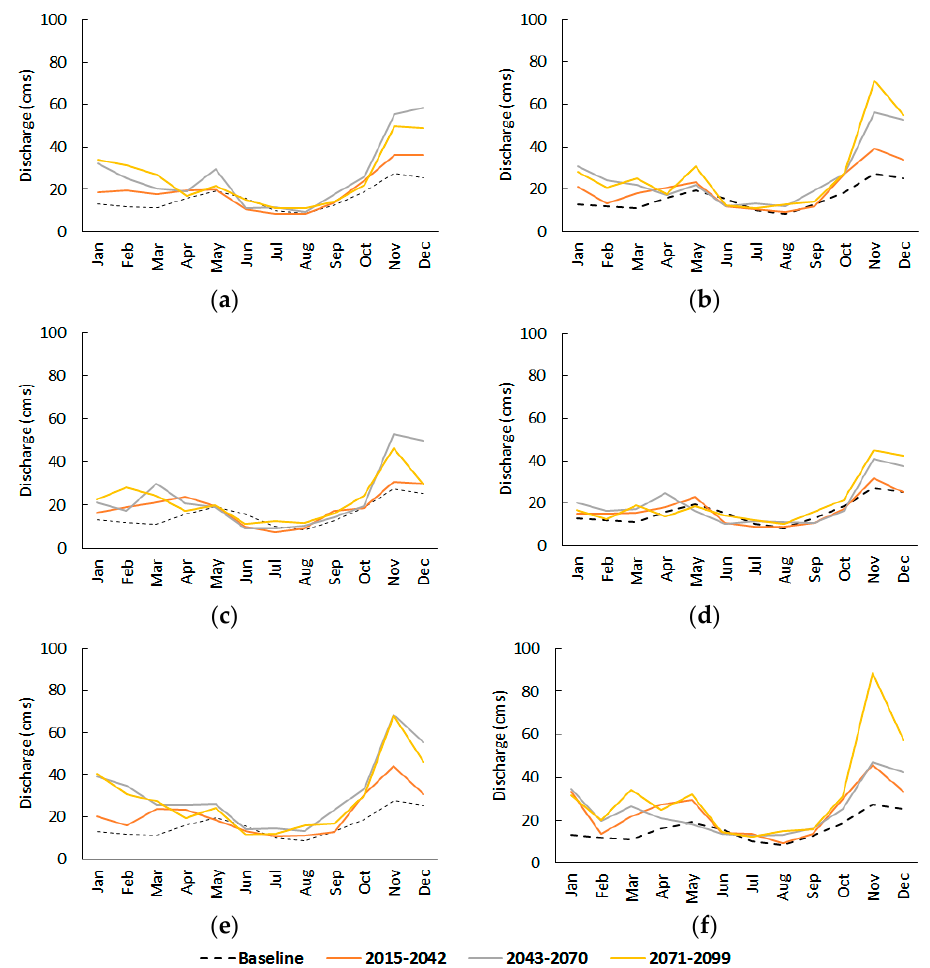
Figure 8. Future mean monthly discharge for near (2015–2042), mid (2043–2070) and far